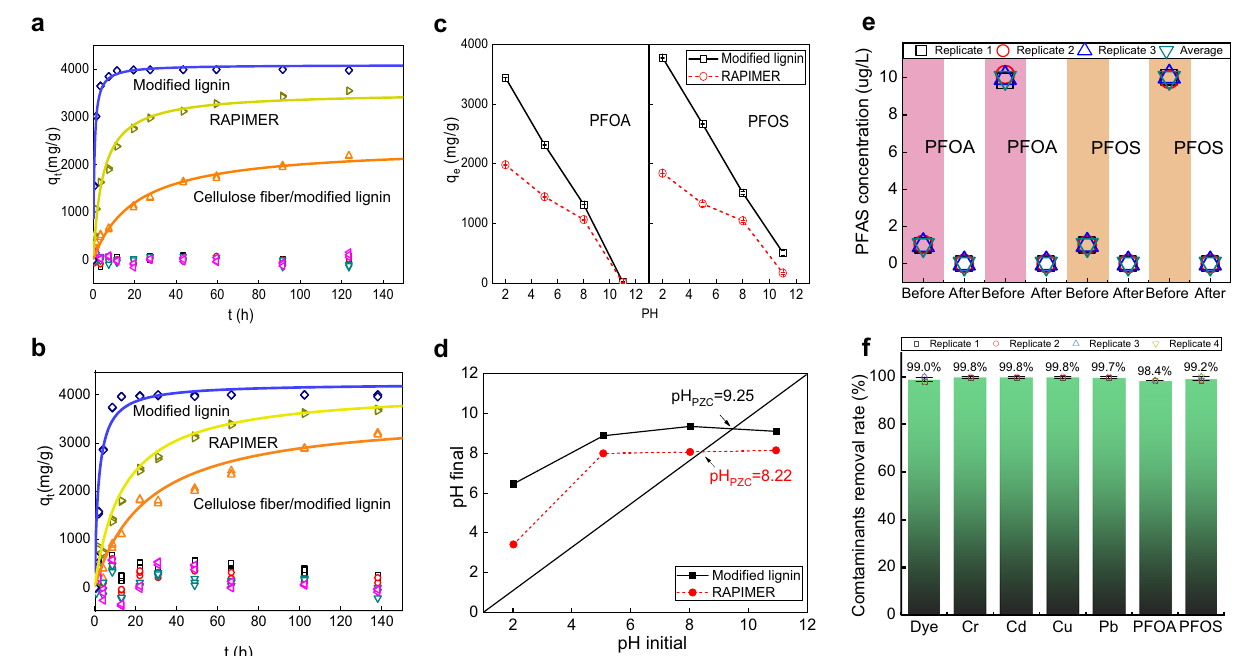
Fig. 3 The characterization of material/PFAS adsorption. a The PFOA adsorption kinetics of the bioinspired composite and their components. b The PFOS adsorption kinetics of the bioinspired composite and their components. Blue diamond and curve: modi fi ed lignin, yellow-green triangle and curve: RAPIMER, orange triangle and curve: cellulose fi ber/modi fi ed lignin composite, green triangle: cellulose nano fi brils, purple triangle: cellulose nano fi bril/ lignin composite, green square: cellulose fi bers. Each time points are triplicate measurements. Due to the small variations, some replicates are overlapped and all points are shown in the fi gures (the invisible standard derivations are not applied in the fi gure due to the small variations). c pH dependence of the modi fi ed lignin and RAPIMER composite adsorption capacity. Red open circle, RAPIMER composite; black open square, modi fi ed lignin. d pH of zero charge of the modi fi ed lignin and RAPIMER composite. Red solid circle, RAPIMER composite; black solid square, modi fi ed lignin. e Adsorption ef fi ciency of the RAPIMER composites for PFOA and PFOS at 1 and 10 µ g/L. The peristaltic pump fi ltration system was employed for this PFAS adsorption measurements (Supplementary Fig. S8). The experiment was reproduced n = 3 times. f Adsorption ef fi ciency of the RAPIMER composites for 1 mg/L PFOS, PFOA, anionic dye, chromium (Cr), cadmium (Cd), copper (Cu), lead (Pb) mixtures in the rain water. The peristaltic pump fi ltration system was employed for this PFAS adsorption measurements (Supplementary Fig. S8). The mean with error bar represents the average value and standard deviation (SD) of experimental replicates. The experiment was reproduced n = 4 times (The ICP-MS measurement was reproduced twice due to the high precision). The Source data is provided as a Source Data fi